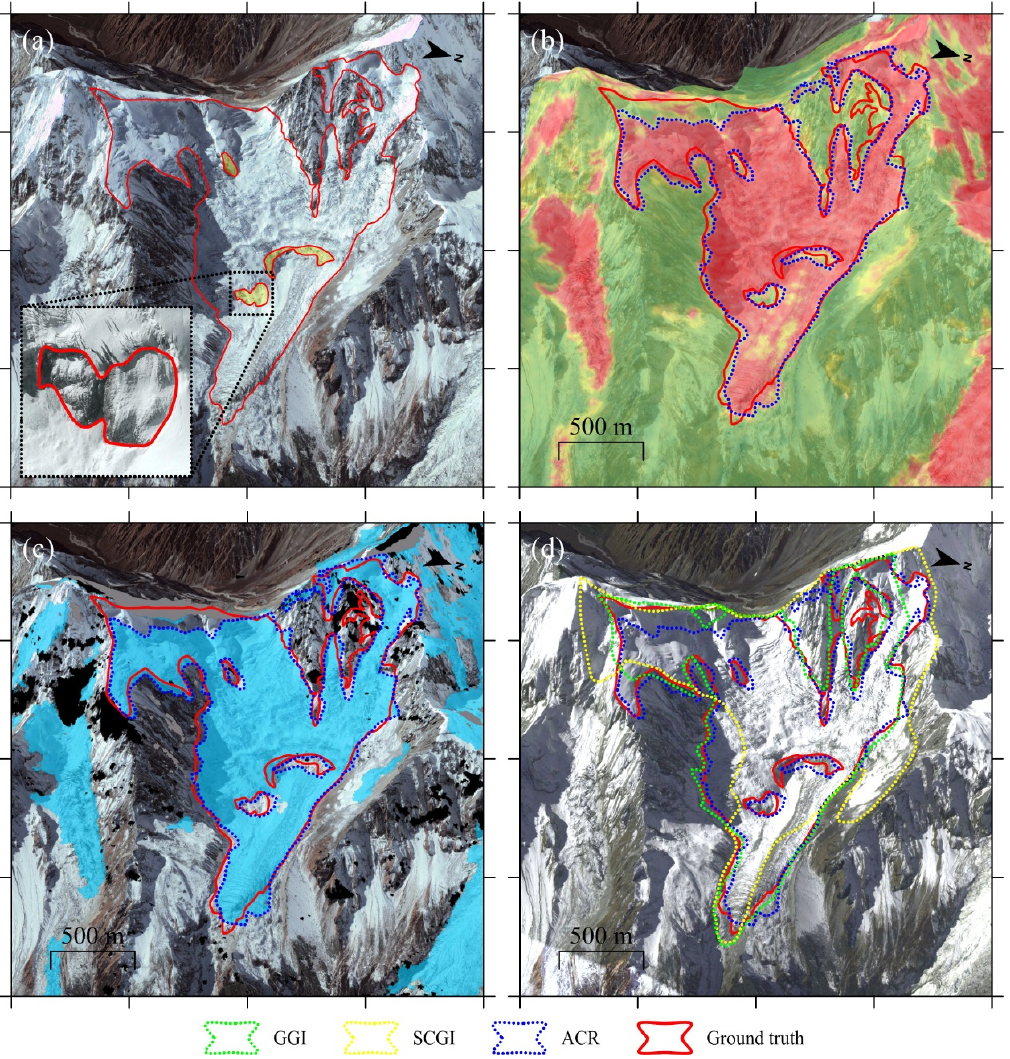
Figure 8. Comparison of ground truth with Google Earth optical images ( a ), ACR maps ( b ), and binarized ACR maps ( c ) for the HLG-2. Comparison of ground truth with GGI, SCGI, and ACR-based glacier boundaries ( d ).